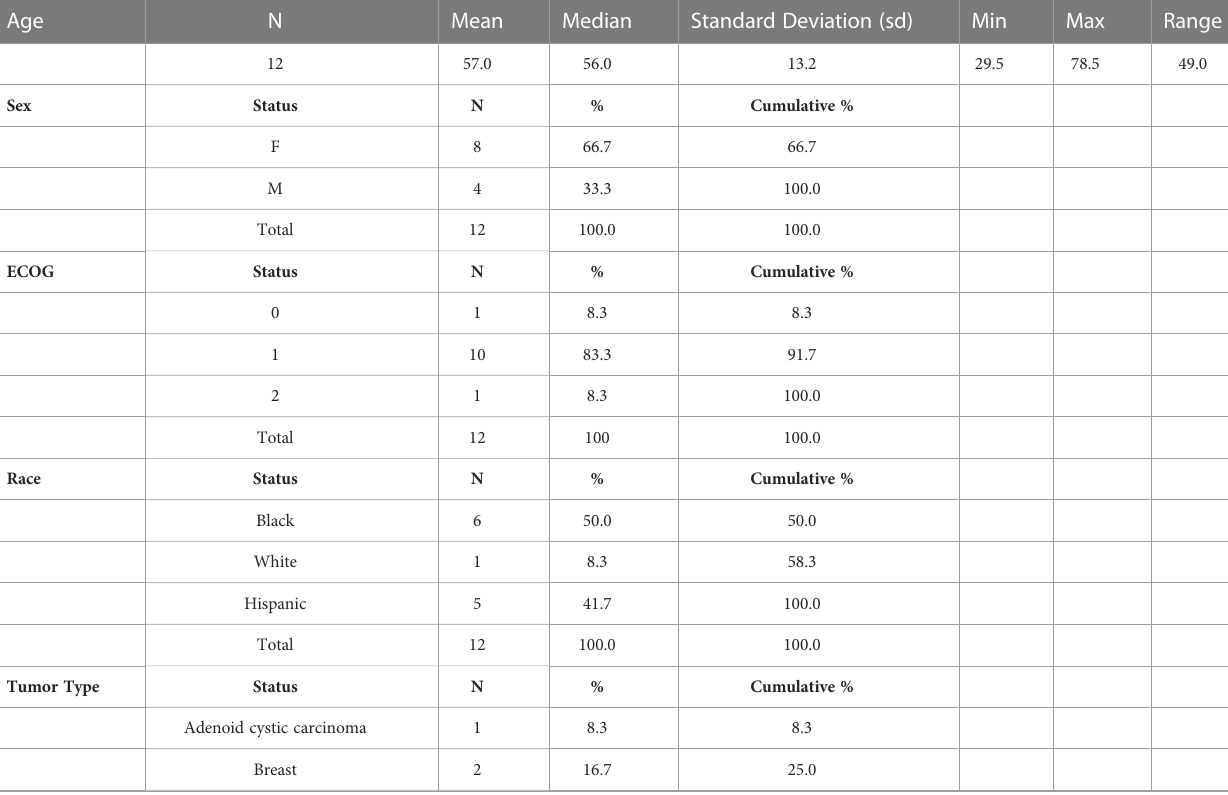
TABLE 1 Baseline characteristics of